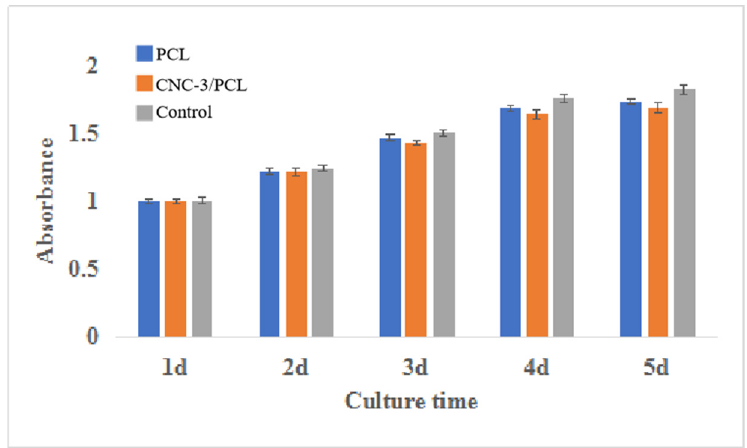
Figure 12. Results of CCK-8 cytotoxicity test.